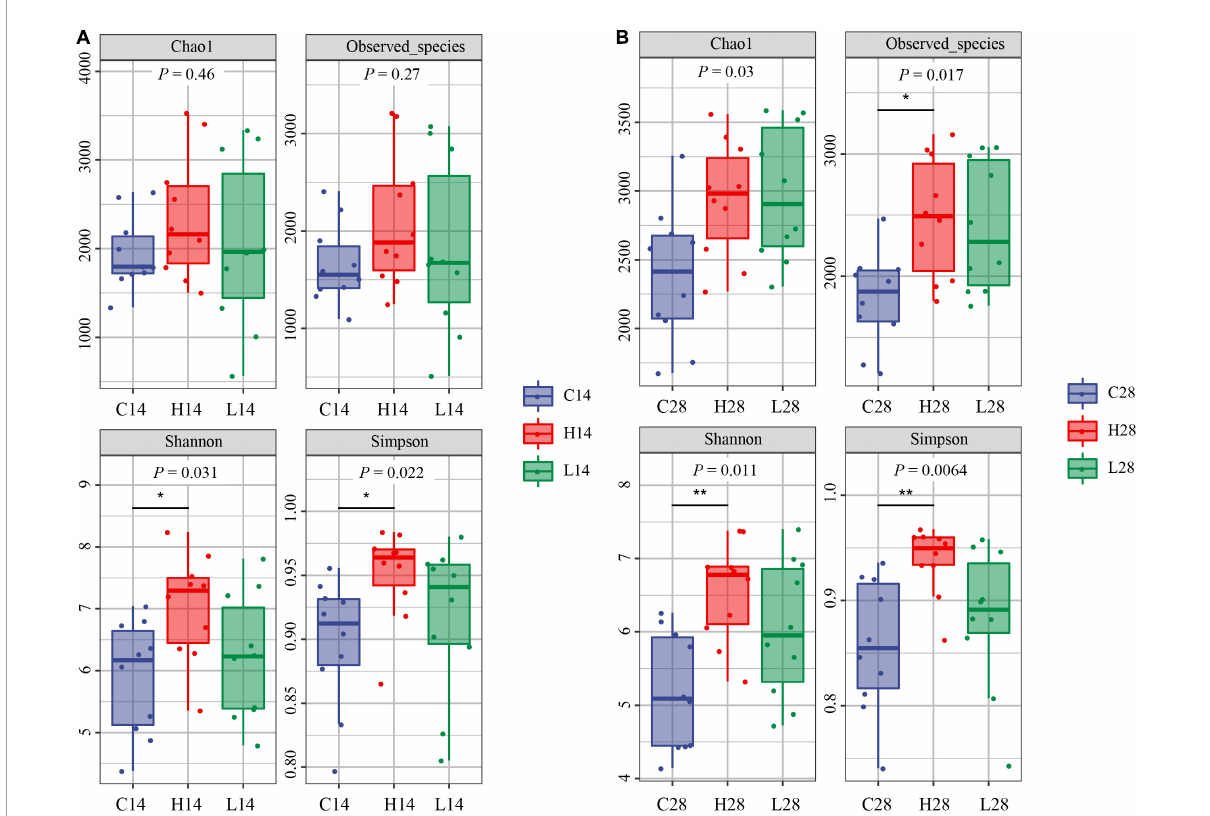
FIGURE2 Comparison of intestinal microbiome alpha diversity index of different temperatures on 14 days (A) and 28 days (B) . C14, H14, and L14 represent the control group, high and low temperature groups treated for 14 days, respectively. C28, H28, and L28 represent the control group, high and low temperature groups treated for 28 days, respectively. * P < 0 . 05 and < 0.01 and ** P < 0 . 01 represented the differences that were